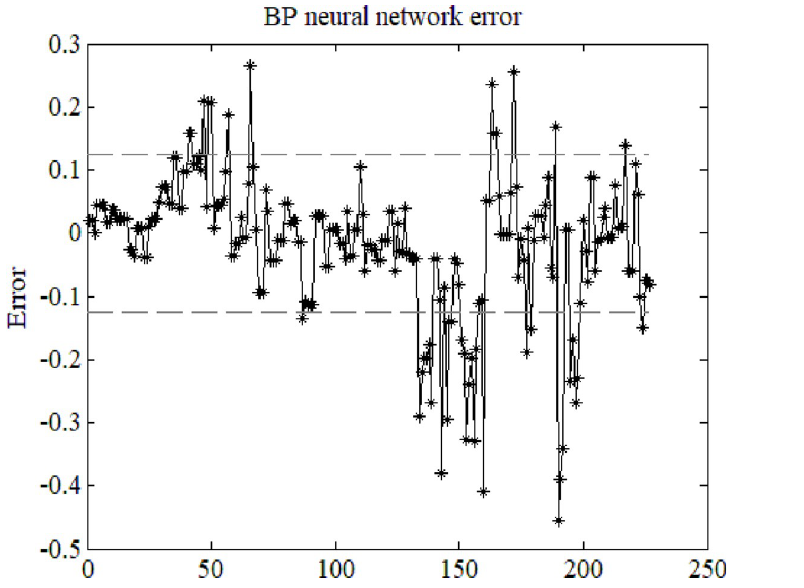
Fig 3. Prediction error with 20 neurons and 120,000 training iterations.